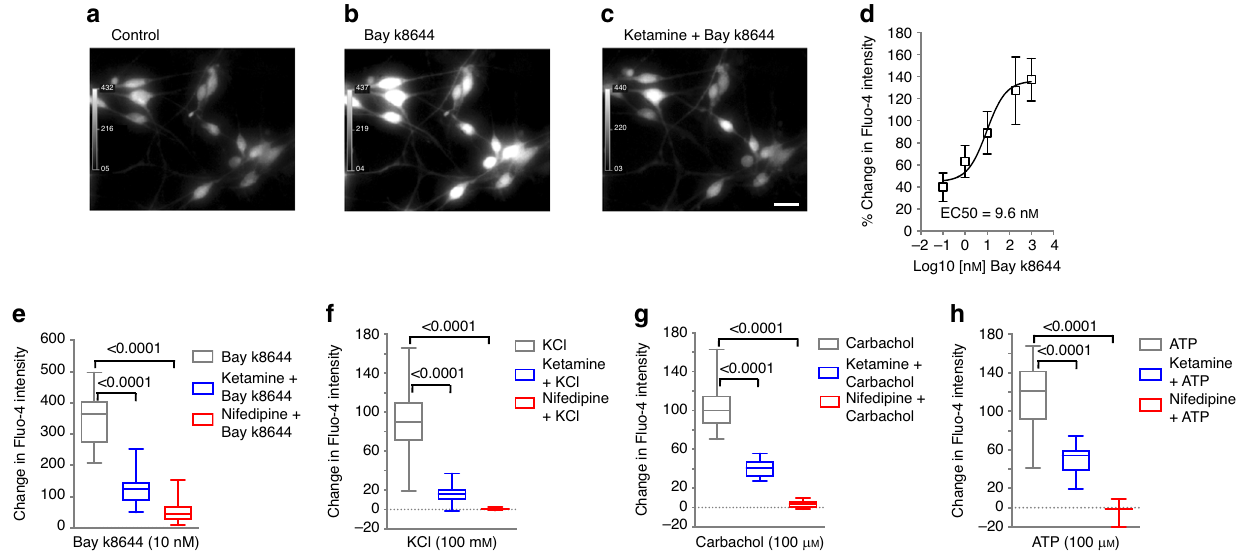
Fig. 5 Ketamine inhibits Cav1.2-mediated calcium in fl ux in mouse BSM cells. a – c Representative Fluo-4 Ca 2 + images of primary cultured mouse BSM cells treated without ( a ) or with Bay k8644 (10 nM) ( b ), or treated fi rst with ketamine (100 µ g ml − 1 ) and then with added Bay k8644 (10 nM) ( c ). Scale bar: 40 µ m. d Nonlinear curve fi t of Bay k8644 concentration-dependent increase in mouse BSM cell [Ca 2 + ] i with EC 50 of 9.6 nM ( n = 10, 23, 18, 19, 10, and 29 BSM cells for respective [Bay k8644] = 0, 0.1, 1, 10, 200, and 1000 nM). Bars indicate the SD of the means. e 10 nM Bay k8644-induced increase in BSM intracellular [Ca 2 + ] ( n = 39 BSM cells) was inhibited by 100 µ g ml − 1 ketamine ( n = 25 BSM cells)) and by 10 µ M nifedipine ( n = 39 BSM cells). f Hundred millimolar of KCl-stimulated increase in BSM intracellular [Ca 2 + ] ( n = 39) was inhibited by 100 µ g ml − 1 ketamine ( n = 25 BSM cells) and by 10 µ M nifedipine ( n = 39 BSM cells). g Hundred micromolar of carbachol-stimulated increase in BSM intracellular [Ca 2 + ] ( n = 27 BSM cells) was inhibited by 100 µ g ml − 1 ketamine ( n = 27 BSM cells), and by 10 µ M nifedipine ( n = 30 BSM cells). h Hundred micromolar of ATP-stimulated increase in BSM intracellular [Ca 2 + ] ( n = 43 BSM cells) was inhibited by 100 µ g ml − 1 ketamine ( n = 22 BSM cells) and by 10 µ M nifedipine ( n = 21 BSM cells). Data are shown as box and whiskers, center line is the median of the data set, box represents 75% of the data, and bars indicates whiskers from minimum to maximum. Data were analysed by two tailed Student ’ s t -test. P < 0.05 is considered to be signi fi cant and P values are given above the bars. Source data are provided as a Source Data fi